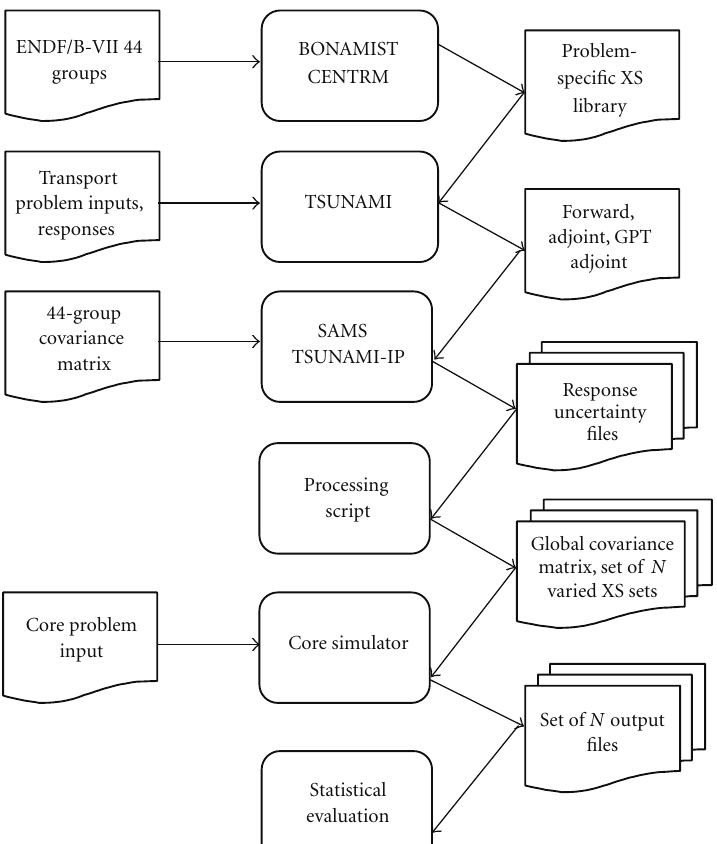
Figure 2: Flow diagram for the proposed two-step method, which mainly utilizes the generalized perturbation theory modules in SCALE